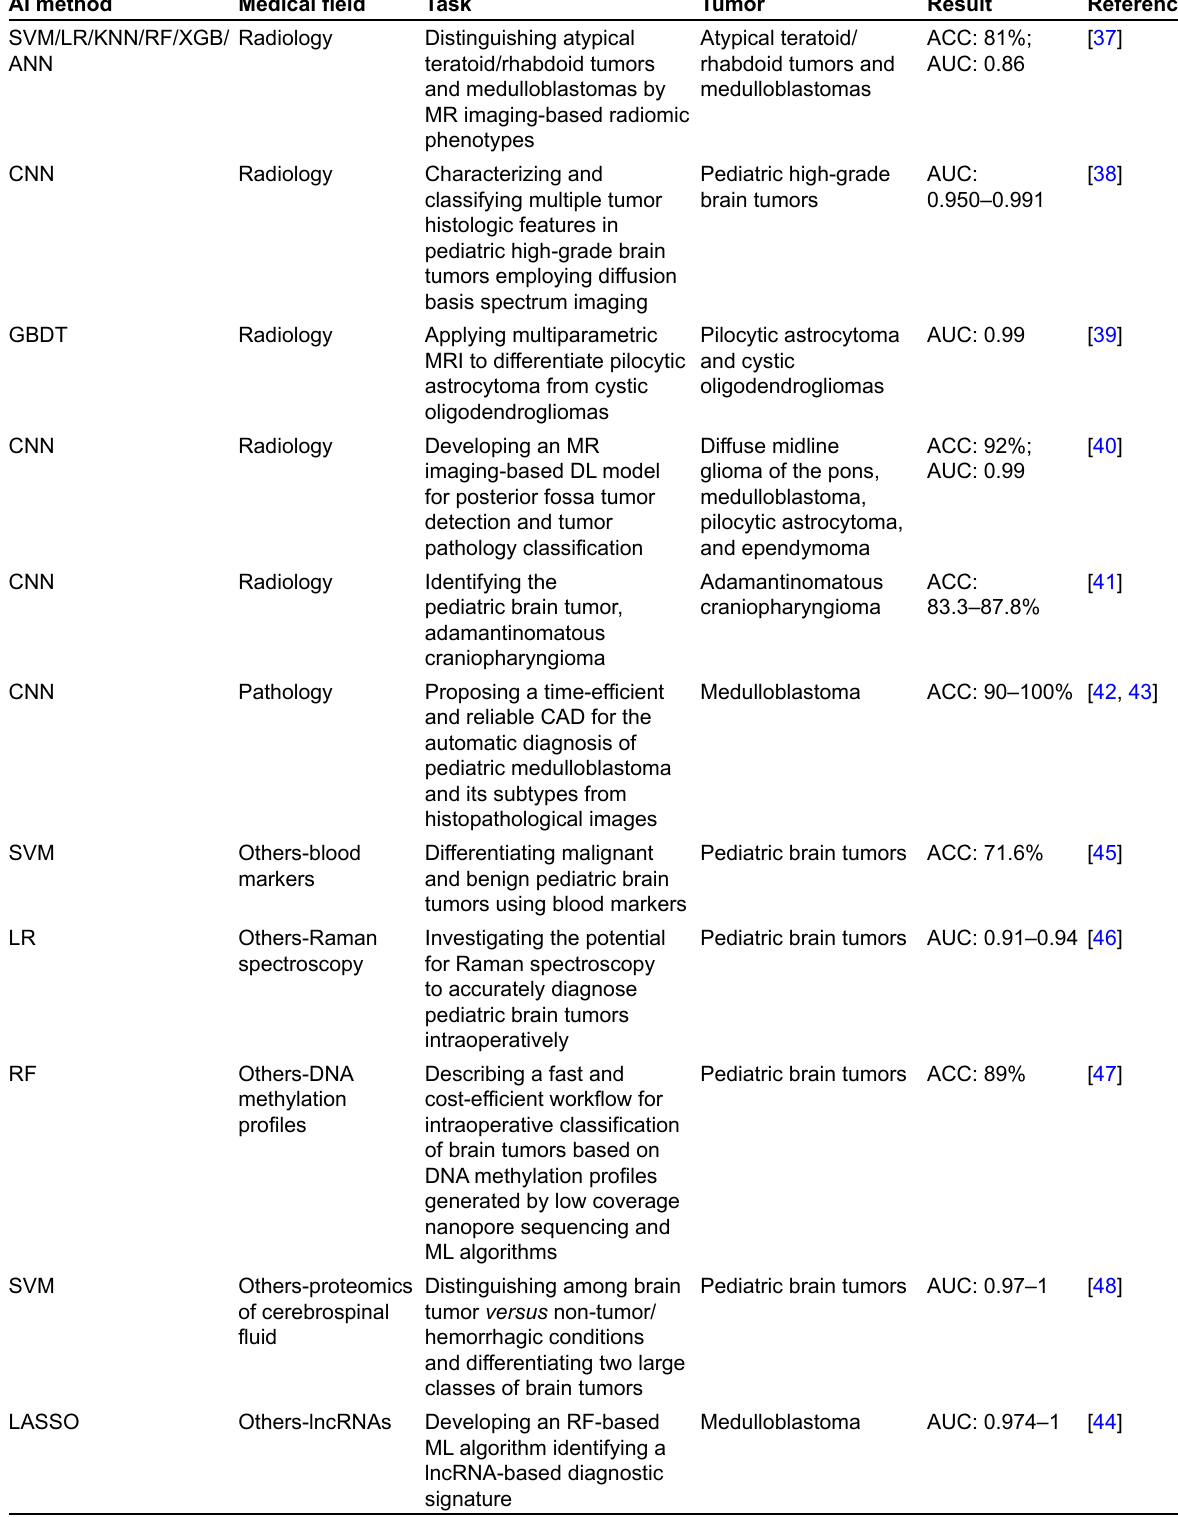
Table 2. Current AI applications in the diagnosis of childhood intracranial tumor ( continued ) AI